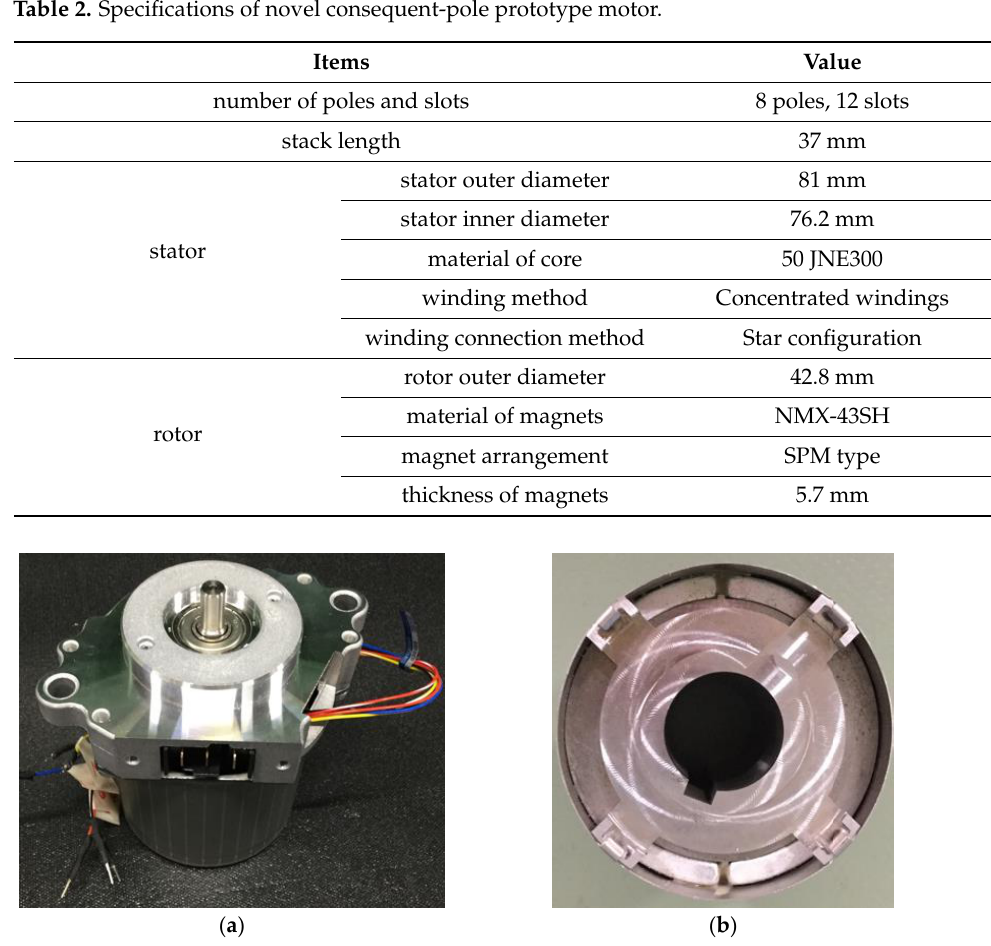
Figure 19. Configuration of prototype motor: ( a ) Photograph of the motor; ( b ) Photograph of the rotor.